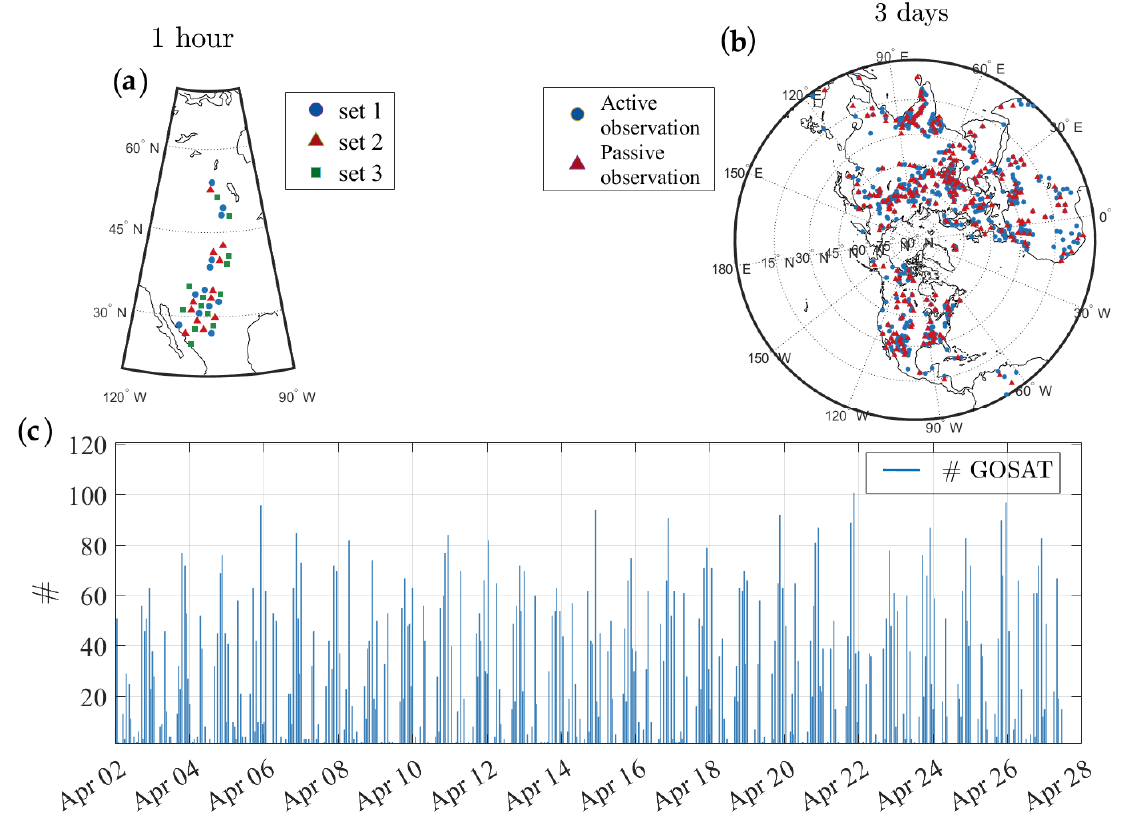
Figure 1. Spatial and temporal distribution of GOSAT methane observations used in cross-validation. ( a ) 1-h GOSAT observations separated in three sets after thinning; ( b ) active observations (blue circles) versus passive observation (red triangles) over 3 days in the cross-validation framework to estimate the covariance parameters; ( c ) frequency of GOSAT observation per hour used in cross-validation.